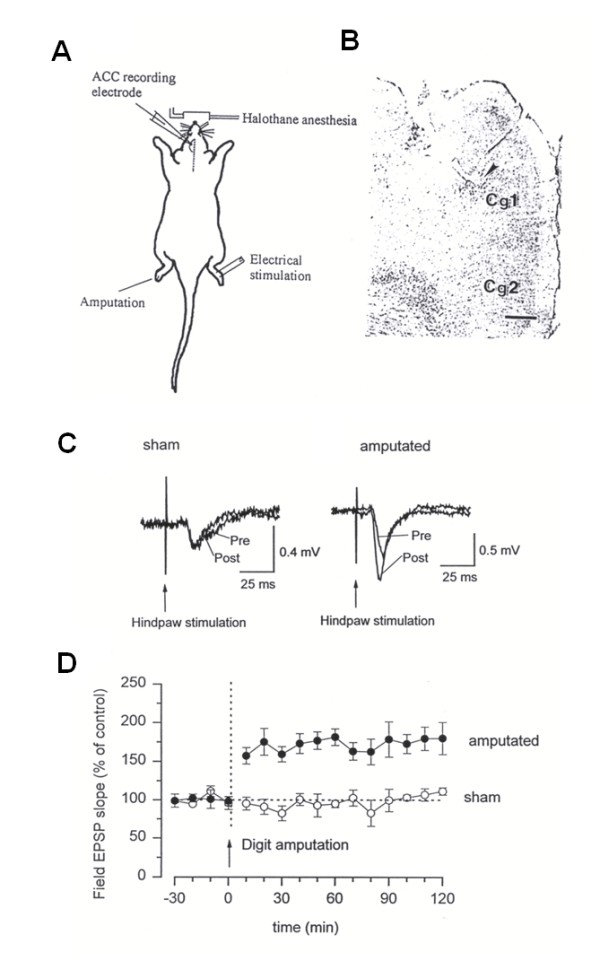
Sensory response of the anterior cingulate cortex to peripheral stimulation in adult rats. A-B, diagram of in vivo recording from the anterior cingulate cortex (ACC) in an anaesthetized rat; animals were maintained in a lightly anaesthetized state by halothane. The recording electrode was placed into the ACC contralateral to the peripheral stimulation electrode. Amputation (the removal of the third digit of the hindpaw) was performed on the non-stimulated hindpaw. During amputation, a higher concentration of halothane was used. C, Long-lasting enhancement following amputation of a single hindpaw digit A, representative traces of EPSPs 5 min before amputation (Pre) and 115-120 min after (Post) sham treatment or amputation. The he latency of sensory responses was not changed after the amputation, while the EPSP slope was increased. D, amputation of a single digit of the contralateral hindpaw (indicated by an arrow) caused long-lasting enhancement of sensory responses (•). Sensory responses were not significantly changed in sham-treated animals (○). The test stimulation frequency was 0.01 Hz (from Reference 54).